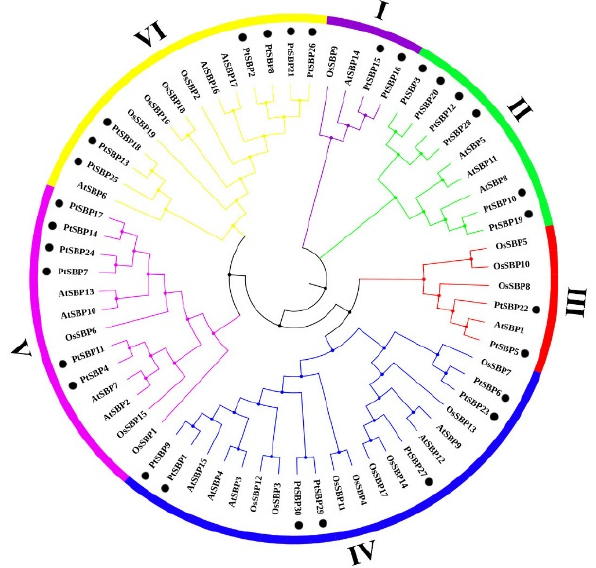
Figure 2. Phylogenetic tree of SBP genes in poplar, Arabidopsis and rice. The rootless phylogenetic trees of poplar, Arabidopsis and rice SBP protein sequences were drawn using the ML maximum likelihood method in MEGA7.0. The gene numbers of 66 SBP genes are listed in Table S4. The phylogenetic tree is divided into six groups: I, II, III, IV, V and VI, regards each color as a group, and poplar SBP genes are marked with ● .